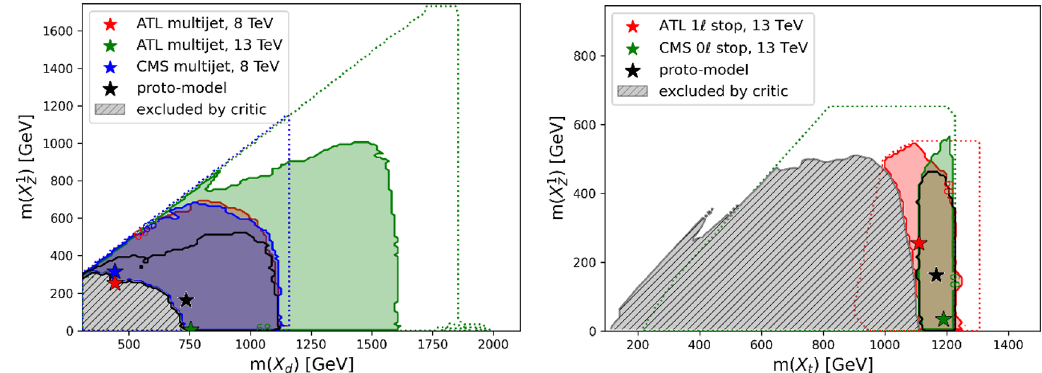
Figure 14 . The 68% Bayesian credibility regions (coloured areas, solid contours) in the mass vs. mass planes of the corresponding simplified model: on the left for ( X ( X 1 ). The signal strength multipliers are fixed at the values of the highest-score proto-model , X 1 t Z with K = 6 . 9 . The coloured stars show the preferred points for each individual analysis, while the black stars display the proto-model parameters. The hatched areas are excluded by the critic. The dashed lines indicate the size of the UL and EM maps provided by the experiments, thus defining the 100% credibility